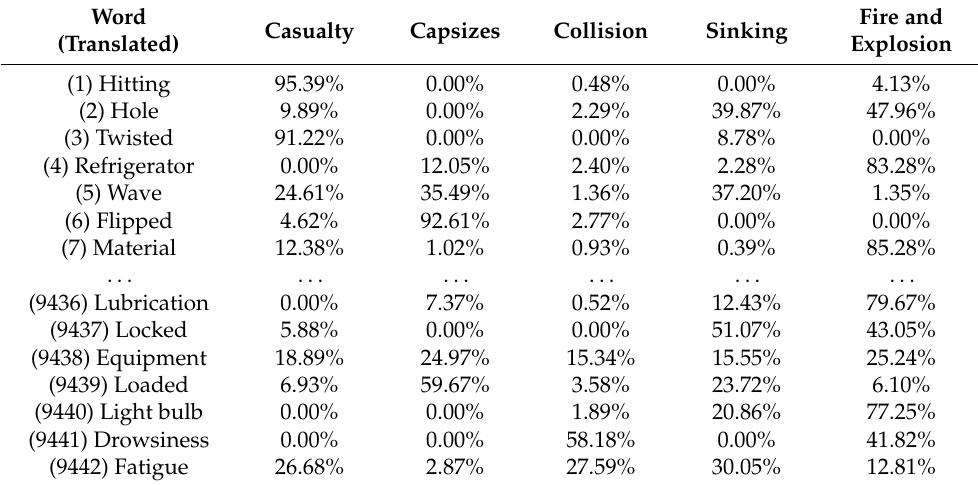
Table 4. Extracted word propensity data.